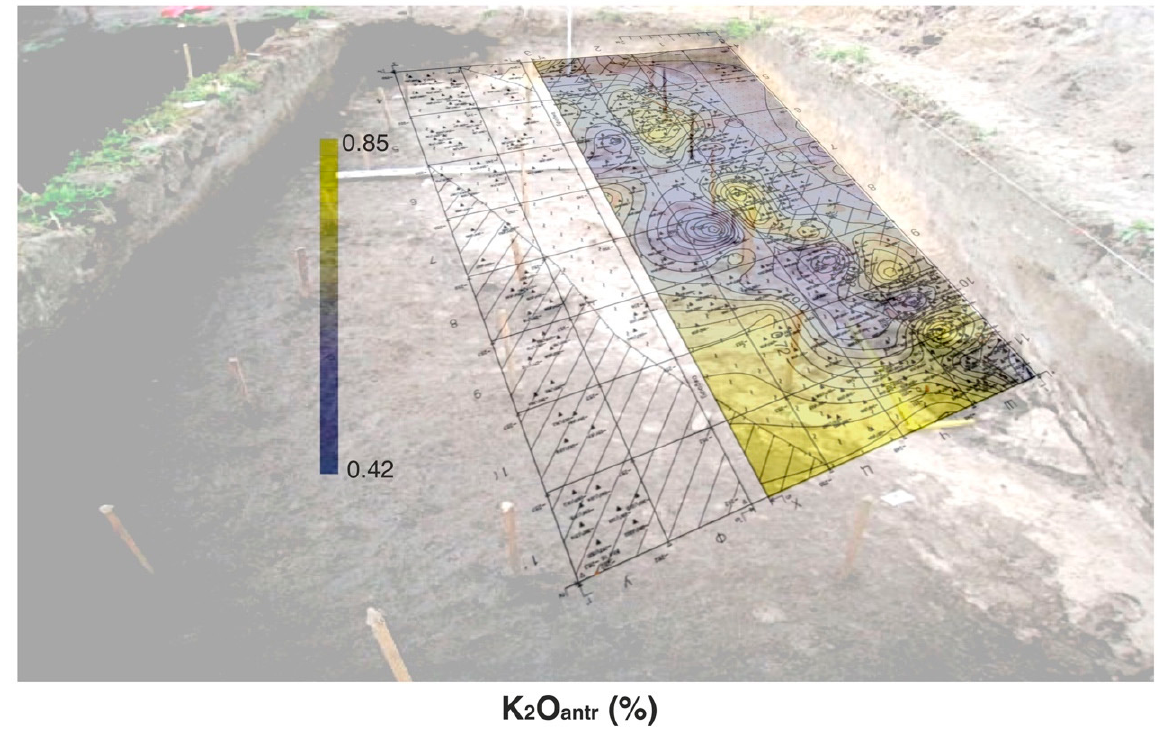
Figure 9. Geochemical map of K 2 O antr distribution in sediments on the surface of the cultural layer at the Podolye 1 site [38], designed by M.Kulkova.